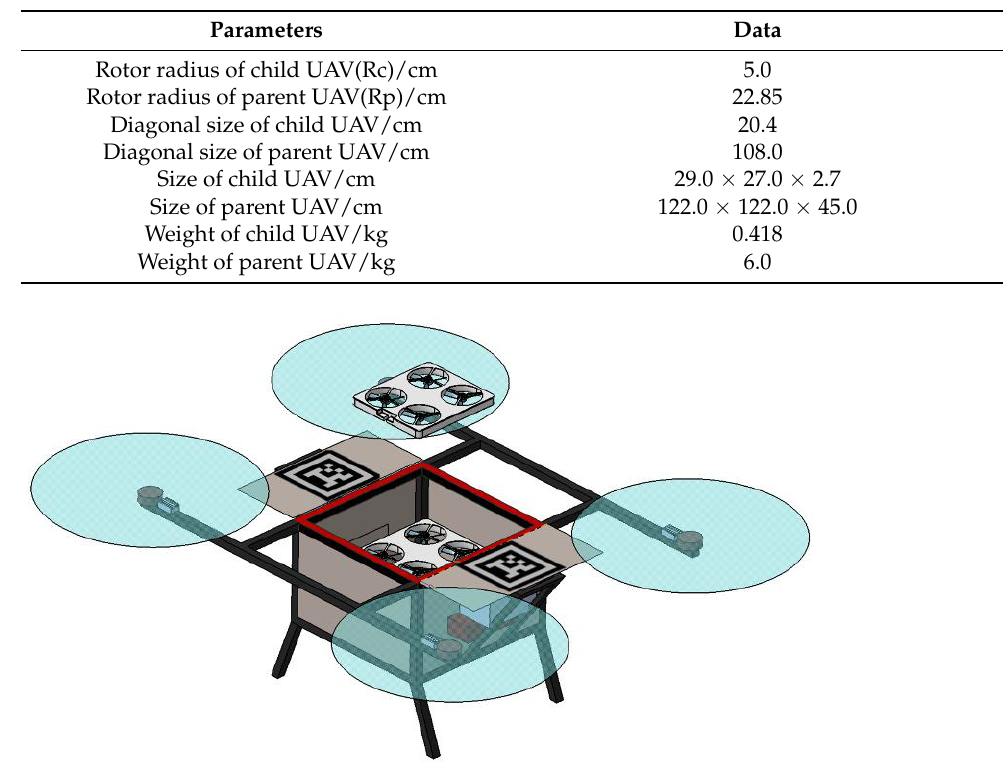
Table 1. Marsupial UAS parameters.